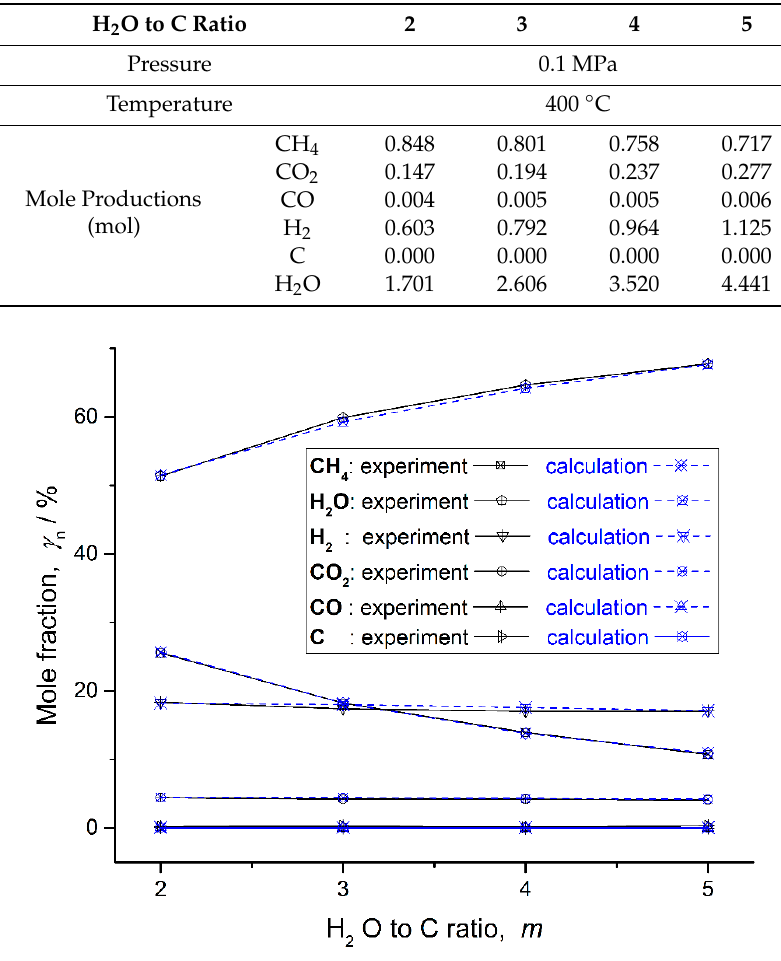
Figure 8. Products of methane-steam reforming under calculation and experiment.